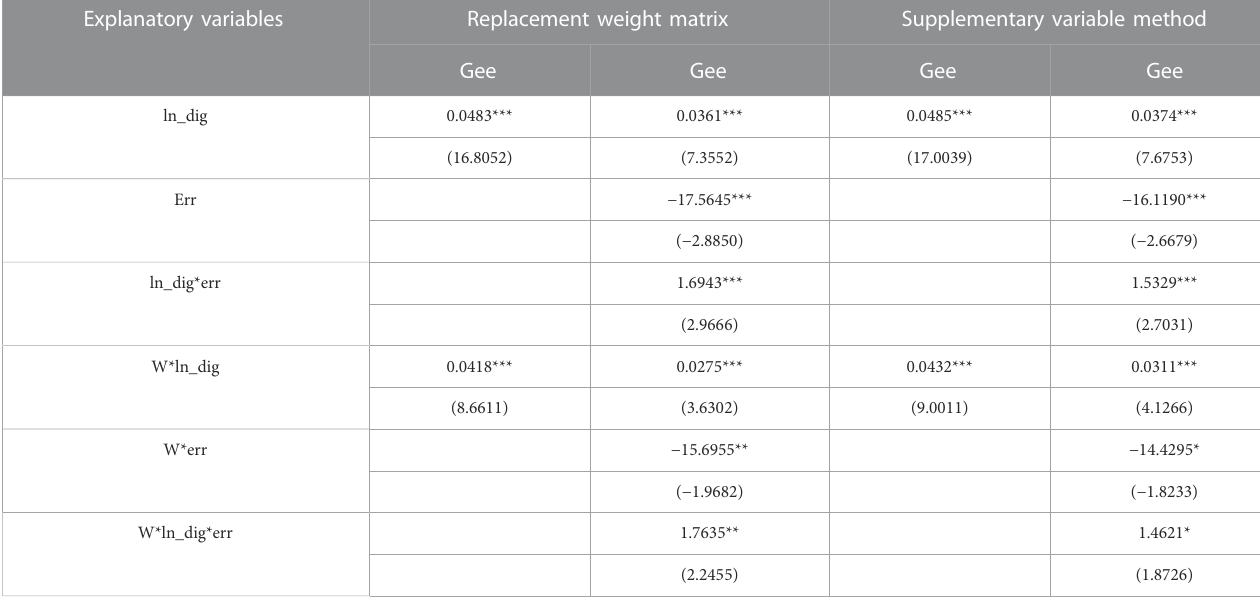
TABLE 8 Robustness test results. Explanatory variables Replacement weight